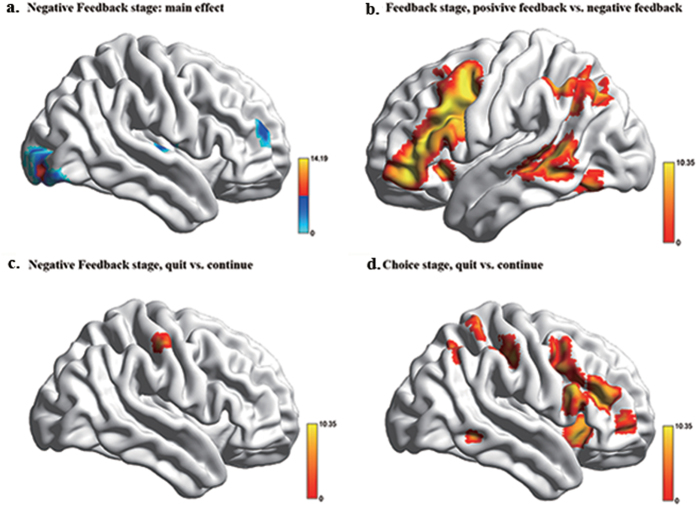
Whole-brain analysis results.(a) Neuroanatomical location of brain regions during the feedback stage. (b,c) Brain regions exhibiting significant increased activation in the contrast between positive and negative feedback (b) and between quitting and continuing with a stimulus set (c) during the feedback stage, and the latter contrast during the choice stage (d). FWE, p < 0.05 corrected and >10 voxels.